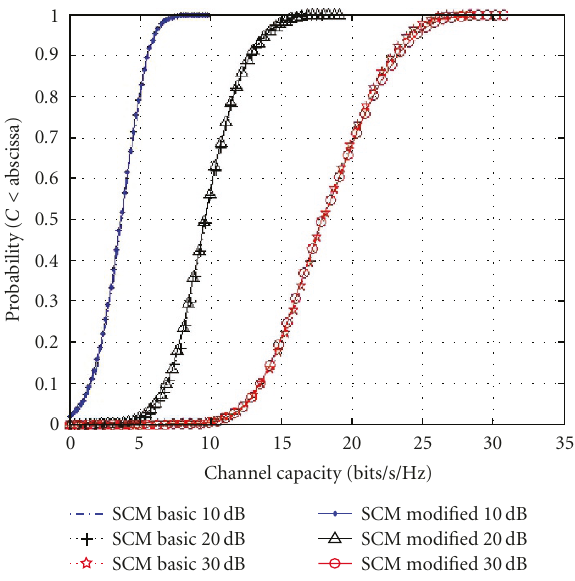
Figure 6: Simulated outage capacity; RMS =